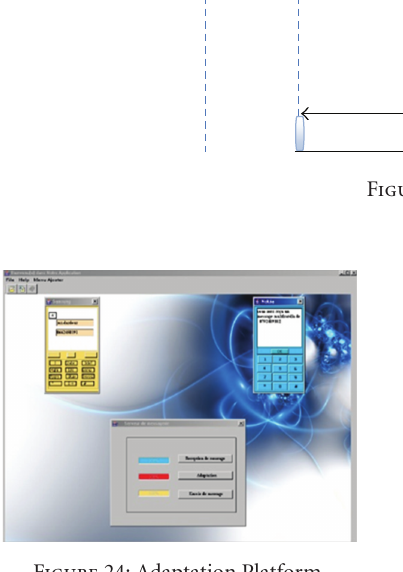
Figure 25: Image